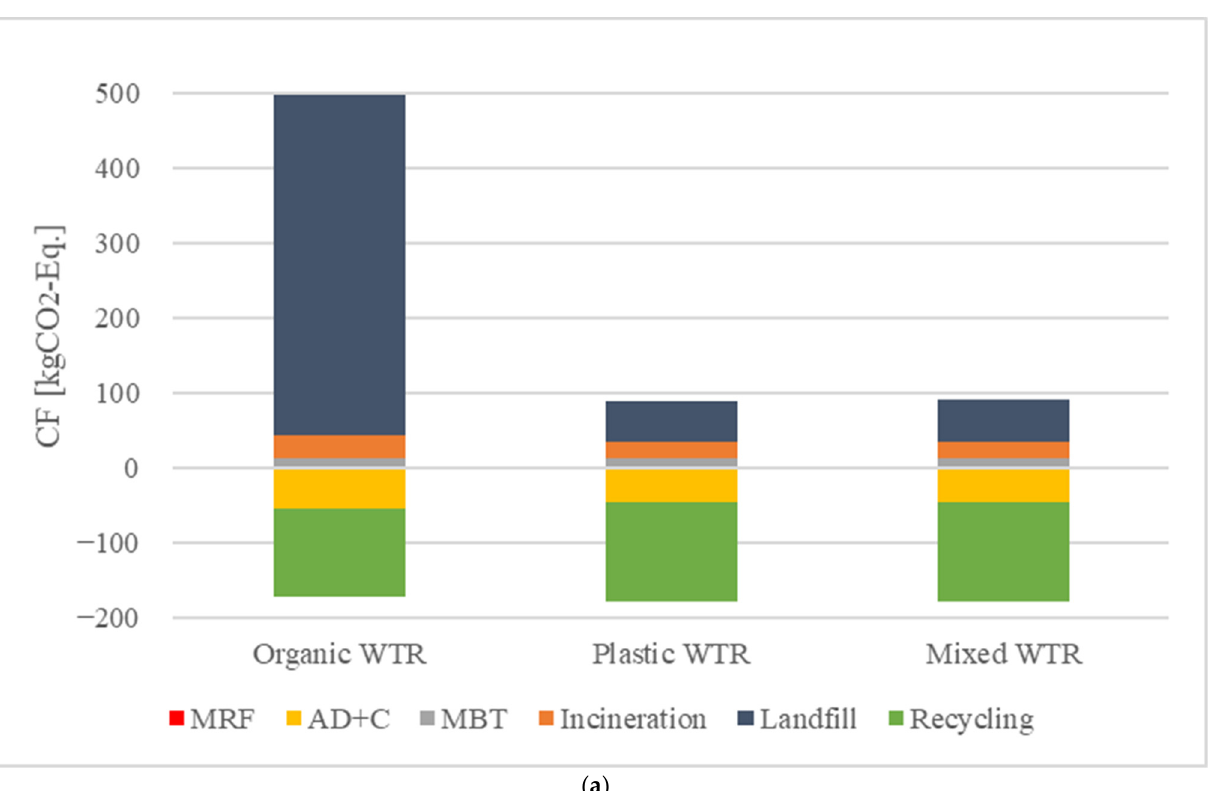
( b ) Figure 4. Carbon footprint results ( a ) and process contribution in the CF value ( b ) of organic, plastic and mixed waste treatment routes.